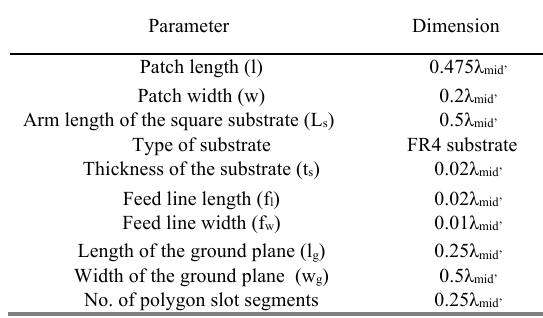
TABLE II. Design Parameters of the proposed PSGPAR.